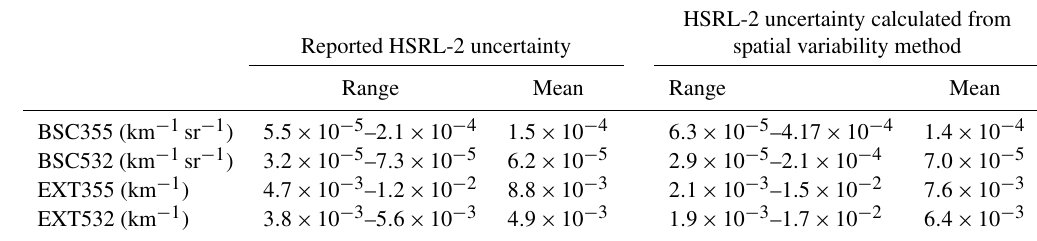
Table 3. Comparison of HSRL-2 reported uncertainty to uncertainties calculated using a spatial variability method for September 2016.